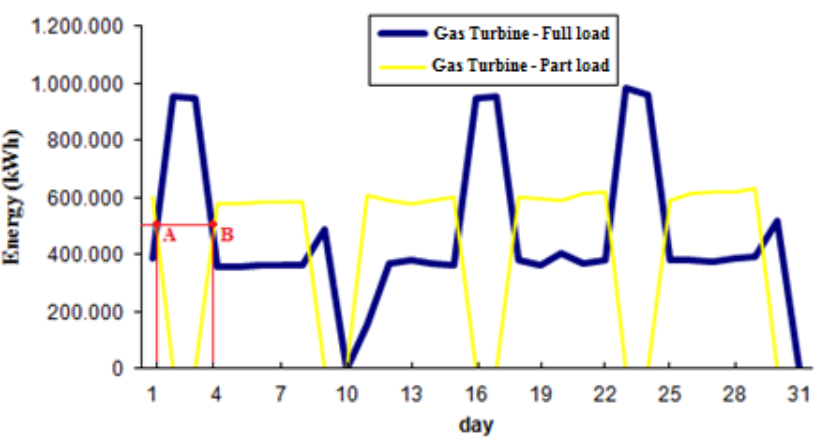
Figure 2. Typical gas turbine load